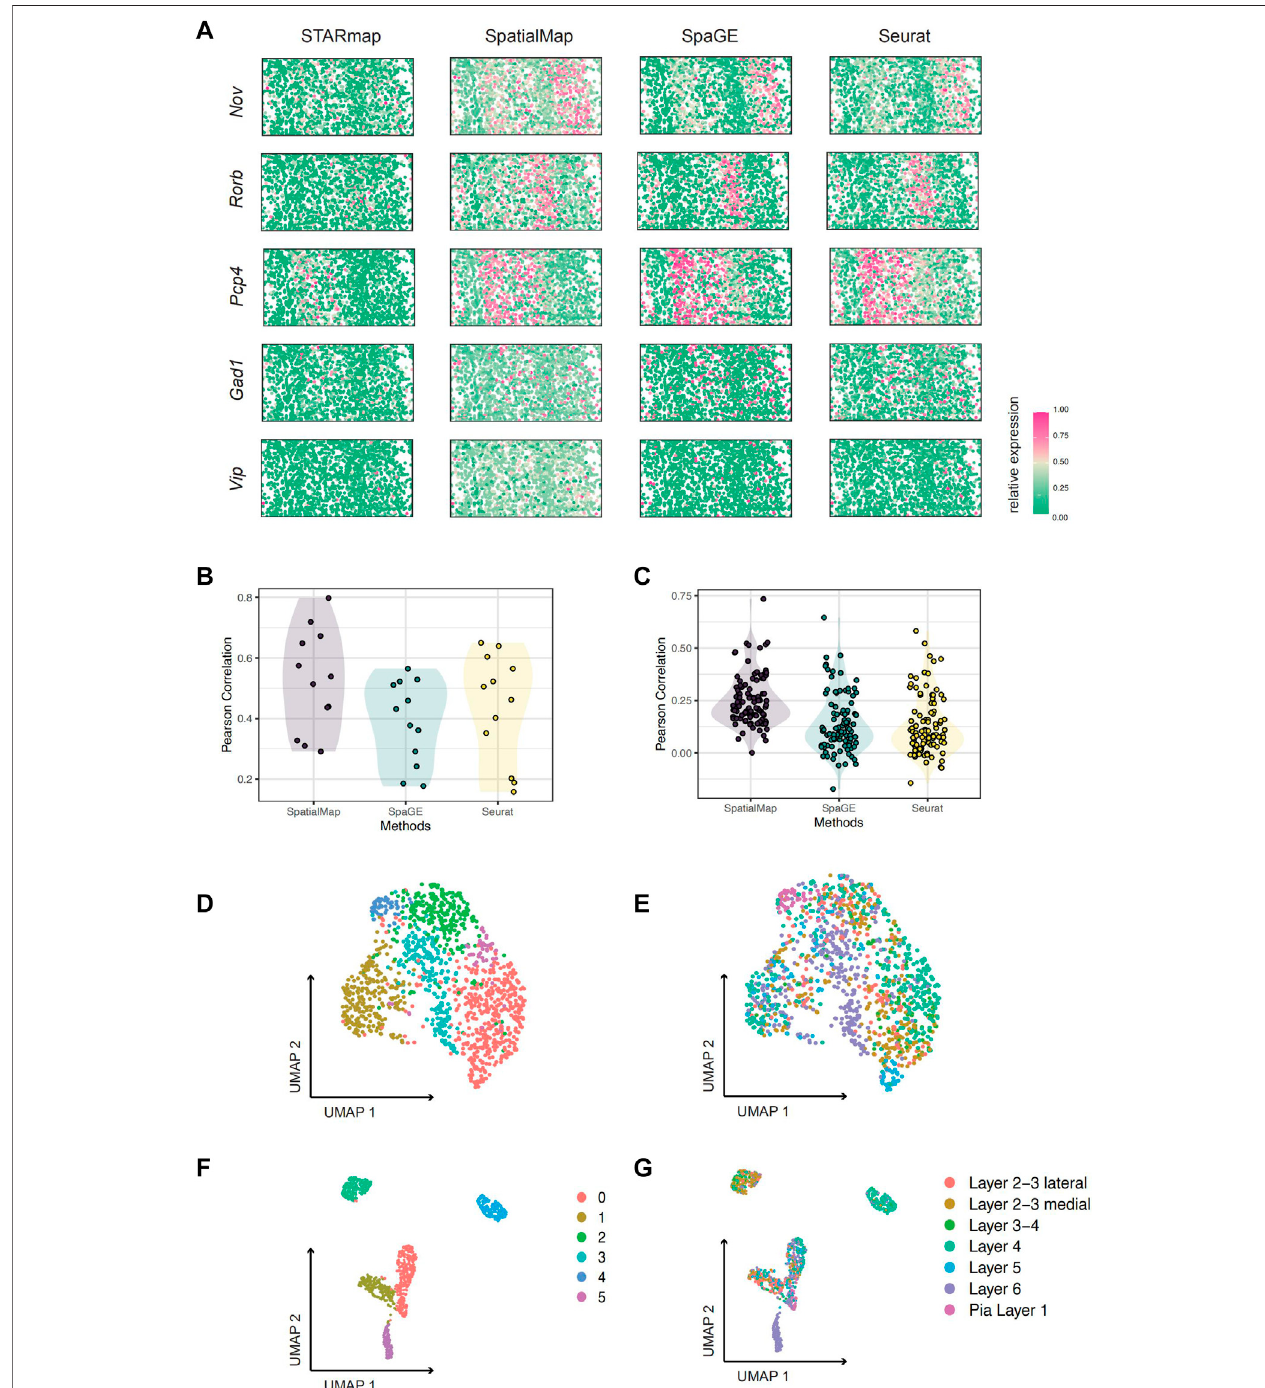
FIGURE2| PerformanceevaluationonSTARmapandosmFISHdatasets. (A) Visualizationofpredictedspatialexpressions.Pearsoncorrelationsare0.320,0.295, 0.518, 0.736, and 0.564 for SpatialMap-performed genes Nov , Rorb , Pcp4 , Gad1 , and Vip , respectively. (B) Pearson correlations between predictions and original values of 11 known marker genes from experiments on the STARmap dataset. The mean values are 0.522, 0.388, and 0.438; minimum values are 0.295, 0.177, and 0.158; and maximum values are 0.736, 0.565, and 0.650 for SpatialMap, SpaGE, and Seurat, respectively. (C) Pearson correlations between predictions and originalvaluesofrandomlyselected100genesfromexperimentsontheSTARmapdataset.Themeanvaluesare0.250(averageat0.194withastandarderrorat0.0235 among 10 repeat predictions), 0.142, and 0.129; minimum values are 0.0005, − 0.172, and − 0.144; and maximum values are 0.734, 0.646, and 0.582 for SpatialMap, SpaGE, and Seurat, respectively. (D – G) UMAP visualization ofclustering performanceon the osmFISH dataset. (D,E) Leiden clusteringand UMAP based on original33 genesfromtheosmFISHdataset,coloredbyclusternumber (D) andcelltypeannotationlabels (E) . (F,G) LeidenclusteringandUMAPbasedon43genesbypredictions using SpatialMap, colored by cluster number (F) and cell type annotation labels (G) . Dots represent individual spatial pixels.